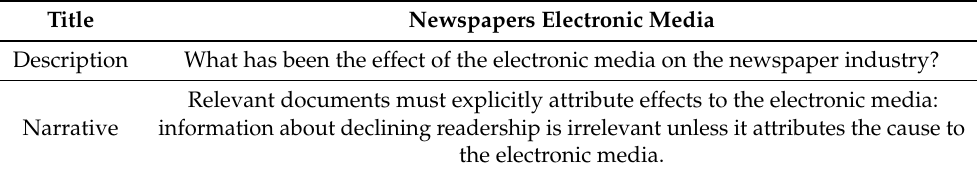
Table 2. Example of query text in Robust04 (Topic